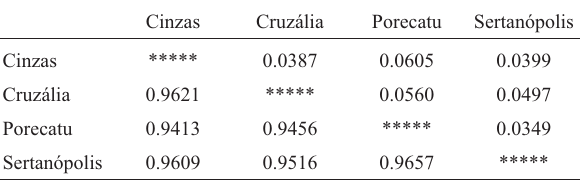
Table 1 - Nei’s (1978) genetic distance (above diagonal) and genetic identity (below diagonal), with Lynch and Milligan correction (1994), between A. altiparanae samples at 4 sites at the Capivara